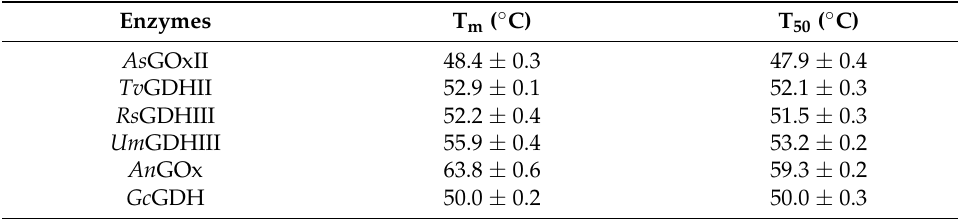
Table 2. Thermostability determination of GOx/GDHs.